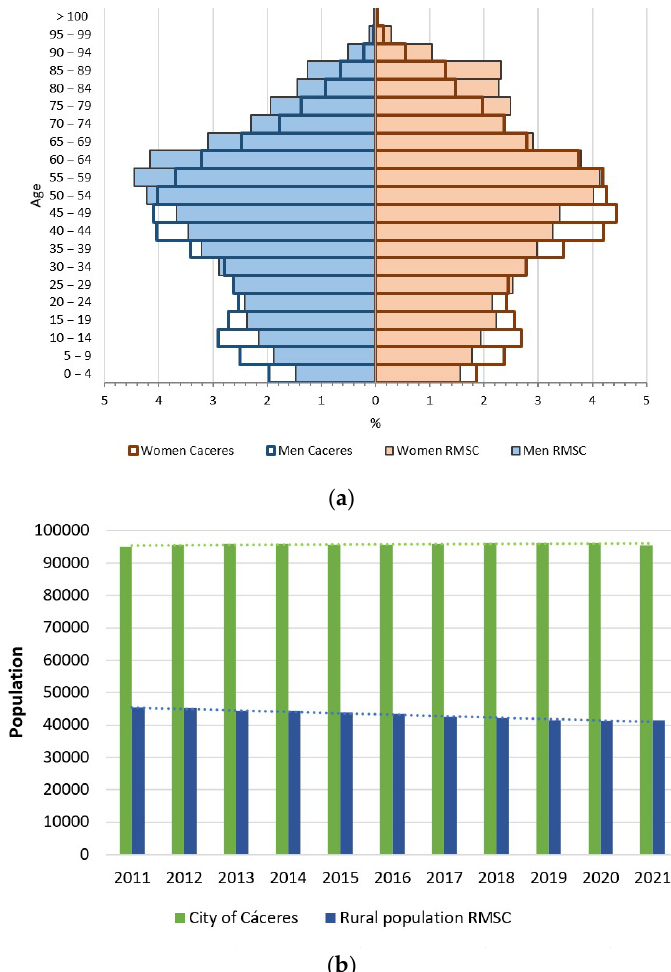
Figure 3. Comparison of the population situation of the study area and the city of Cáceres: ( a ) Population pyramid of Cáceres and the RMSC; ( b ) Evolution of the population of Cáceres and the RMSC 2011–2021.